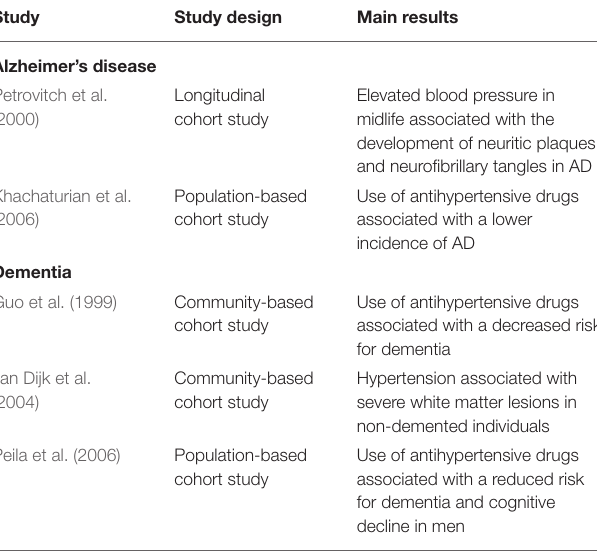
TABLE 3 | Epidemiological studies investigating the association between AD, dementia, cognitive impairment and cardiovascular